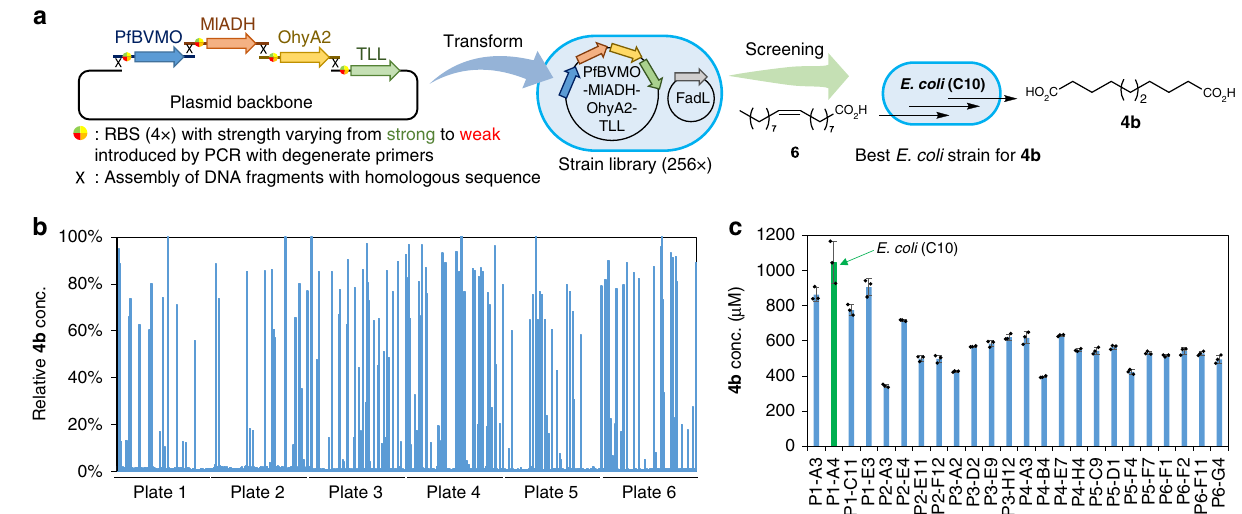
Fig. 6 Engineering and screening a strain library for the production of sebacic acid ( 4b ) from oleic acid ( 6 ). a Construction of a plasmid library for the co- expression of PfBVMO, MlADH, OhyA2, and TLL with different expression levels, and screening of the resulting E. coli library to identify the most effective strain for the production of sebacic acid ( 4b ). All E. coli strains included an additional plasmid harboring the fatty acid transporter FadL. b Initial screening of 576 strains in six 96-well plates for production of sebacic acid ( 4b ). c Further validation and comparison of 24 strains (best four from each plate) for the production of sebacic acid ( 4b ). The green column indicates the best strain E. coli (C10). The reactions were performed using oleic acid ( 6 ) (5 mM) and E. coil (10 g l − 1 ) in KP buffer (200 mM, pH 8.0, 1% glucose) at 30 °C for 24 h. Source data are provided as a Source Data fi le. Data in c are mean values of triplicate experiments with error bars indicating standard deviations (n =